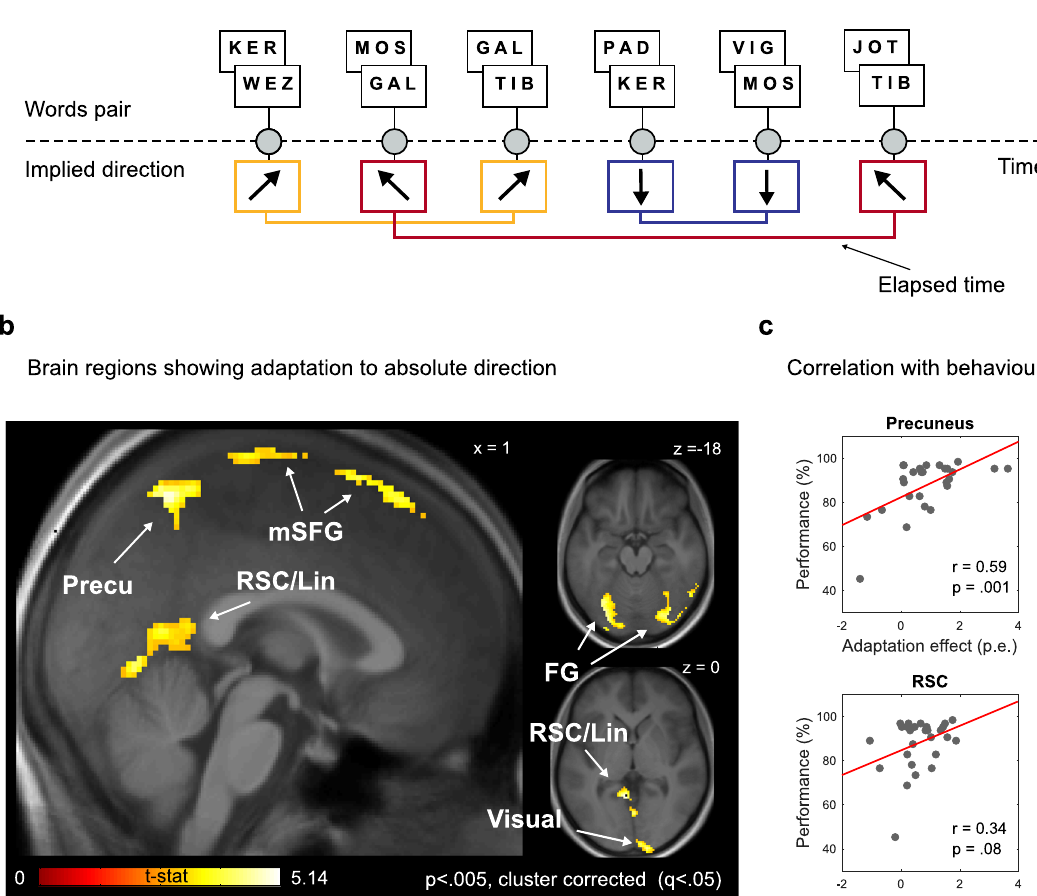
Fig. 2 Results. a We modelled the sequence of trials presented during each run taking into account, for each direction implied by a word pair, the elapsed time from the last presentation of the same direction in the conceptual space (see ‘ Methods ’ ). b Brain regions showing adaptation to the direction of movement in the conceptual space during the semantic comparison task, after removing brain regions responding to confounding factors (see ‘ Methods ’ and Supplementary Fig. 1A). Results are thresholded at p < 0.005, FDR-corrected at cluster level with q < 0.05. Group-level effects are plotted onto an average of subjects ’ structural images. Precu = precuneus; RSC = retrosplenial cortex; Lin = lingual gyrus; mSFG = medial superior frontal gyrus; FG = fusiform gyrus; Visual = visual cortex. c Correlation between performance during the semantic comparison task and the adaptation effect in the precuneus ( r = 0.59) and in the retrosplenial cortex ( r =